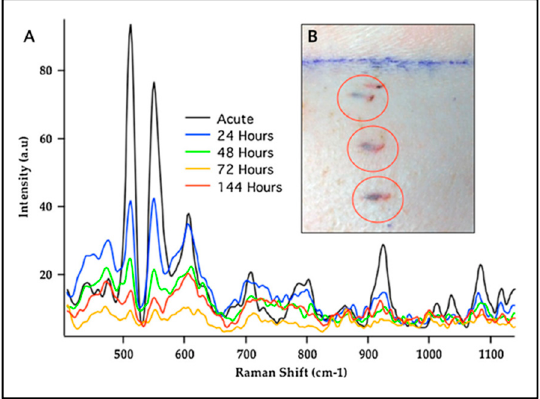
Figure 5. ( A ) SERS Spectra of Cy7-labeled NS embedded in porous scaffold and intradermally implanted in pig dorsum (100 ms acquisitions, 30 mW, 785 nm excitation). ( B ) Three individual intradermally injected implants after 48 h. Adapted from [48].